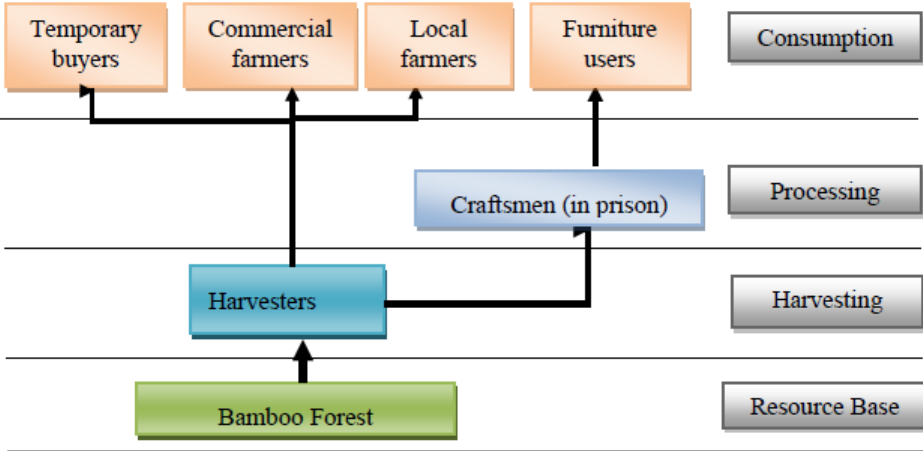
Figure 5. Typical value chain structure from Sheka.